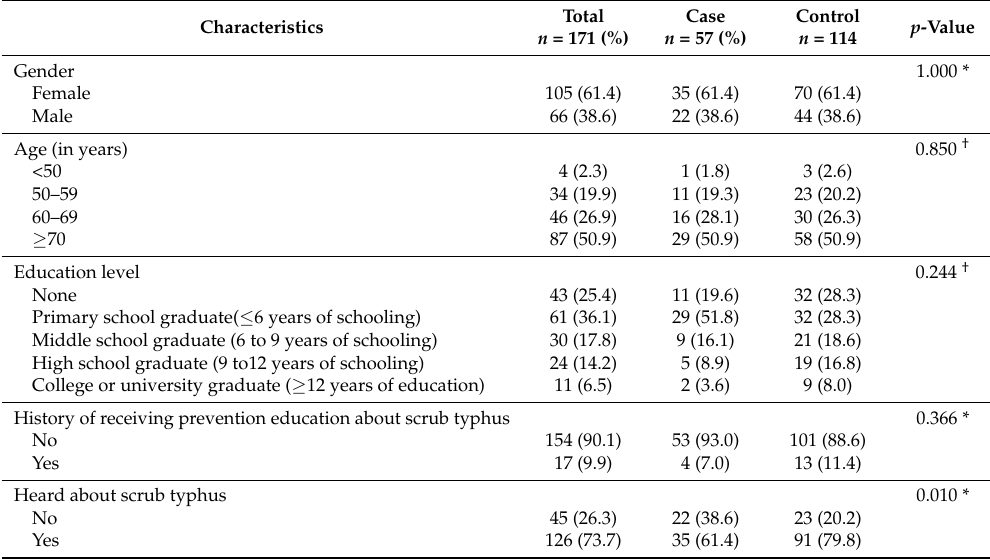
Table 1. Baseline characteristics of scrub typhus cases and